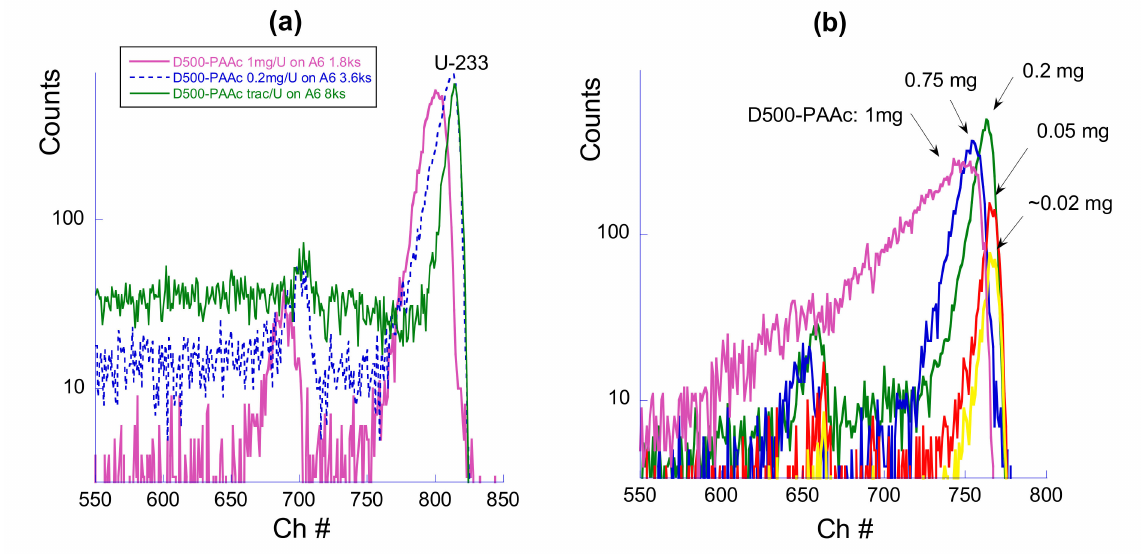
Figure 4. Alpha spectra of A6 UF membranes after the retention of D500-PAAc/U complexes using Approach 1 ( a ) and Approach 2 ( b ) with different concentrations of the polymer (the total mass of deposited polymer is